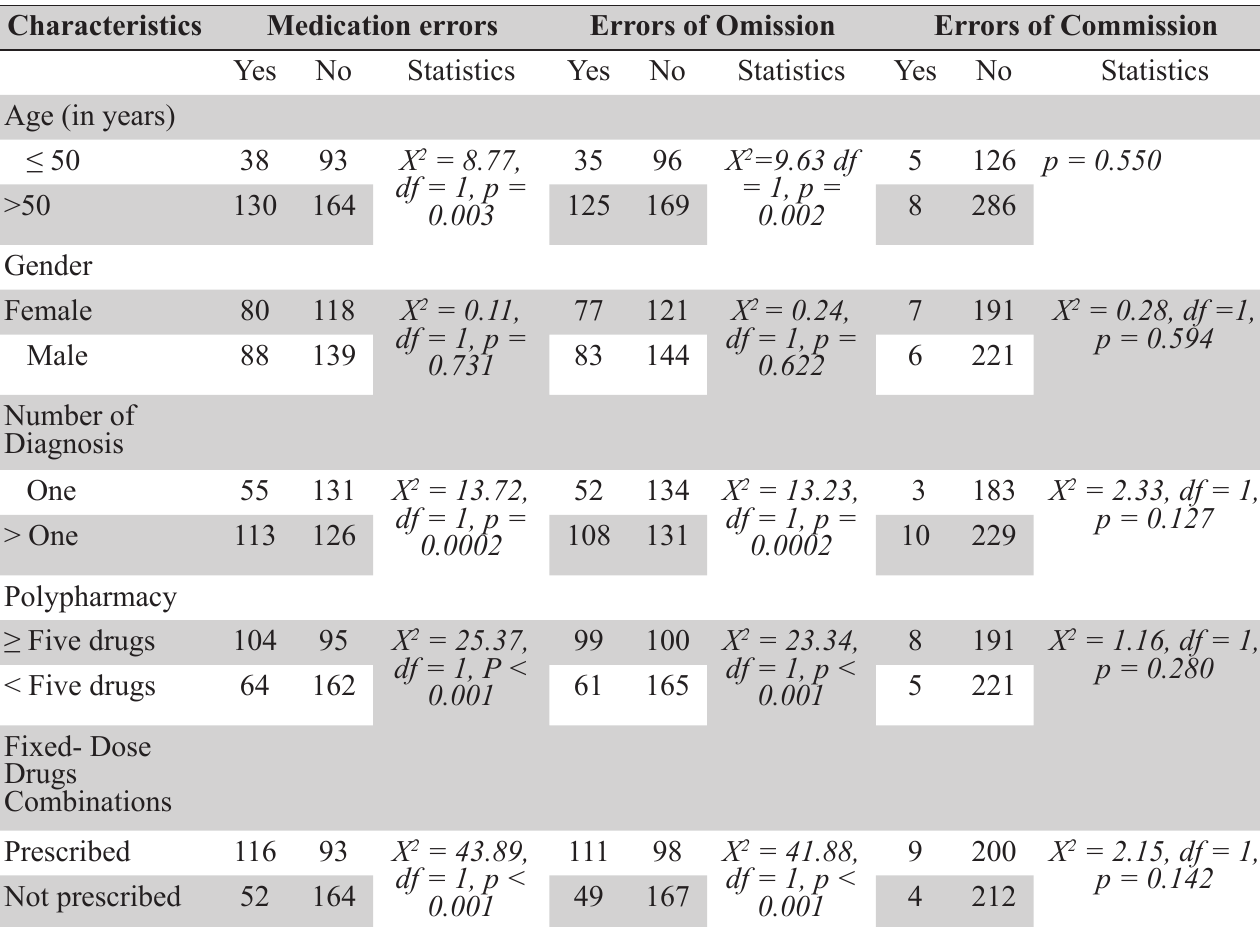
Table 3. Association of socio-demographic and clinical characteristics with prescription errors, errors of omission and errors of